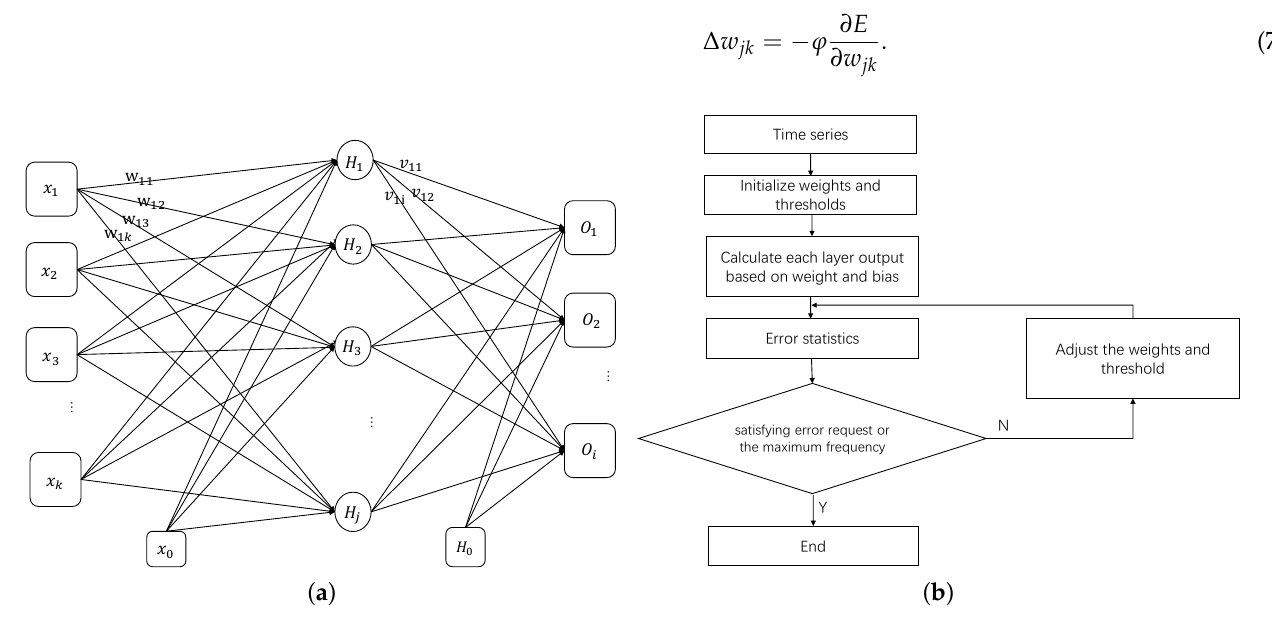
Figure 2. ( a ) The simple structure of the back propagation (BP) neural network. ( b ) The flowchart of the BP neural network.